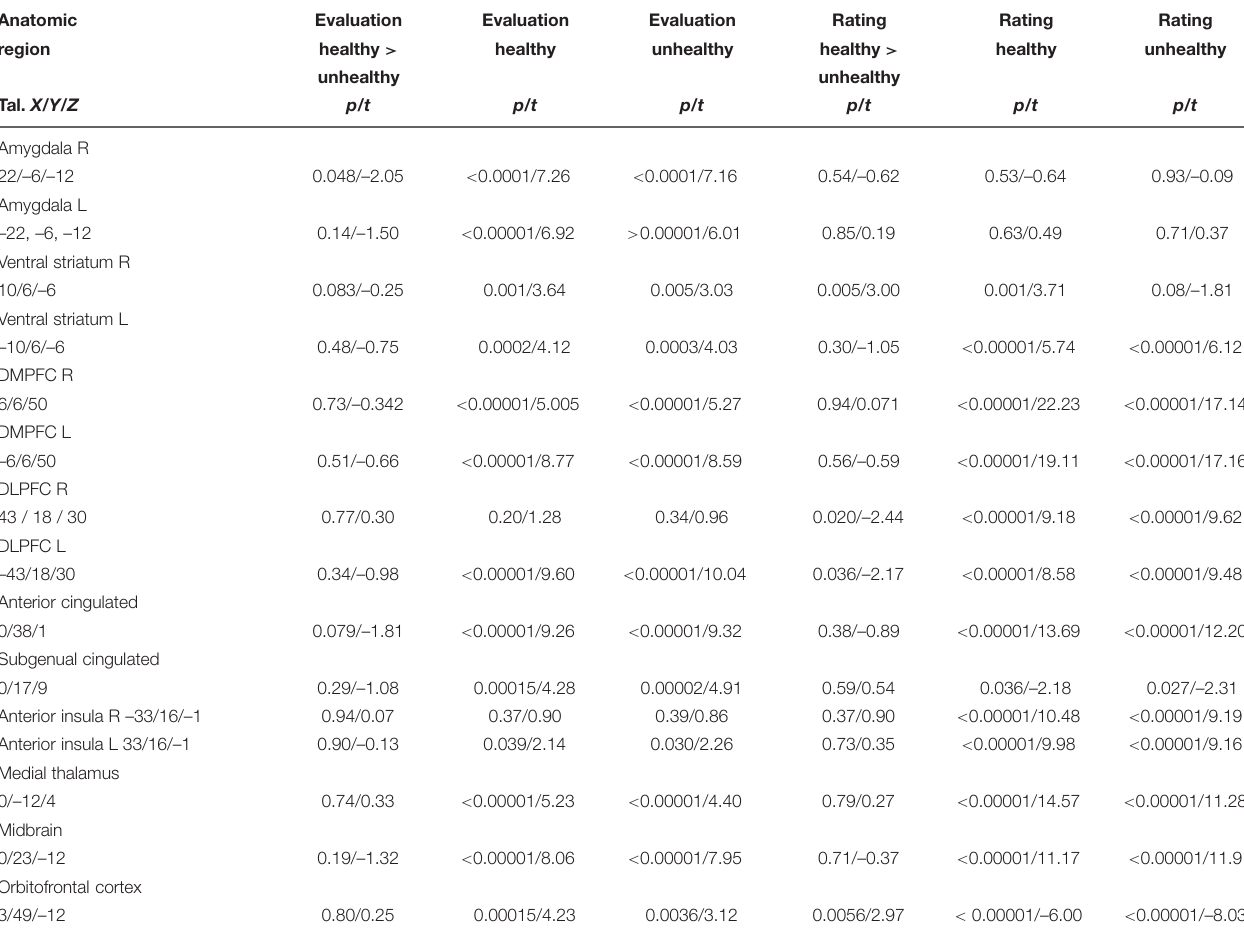
TABLE 3 | Results of the comparisons of the conditions healthy and unhealthy in different regions of interest providing statistical p - and t -values for each, the evaluation (Eval) and the rating (Rat) periods. Anatomic